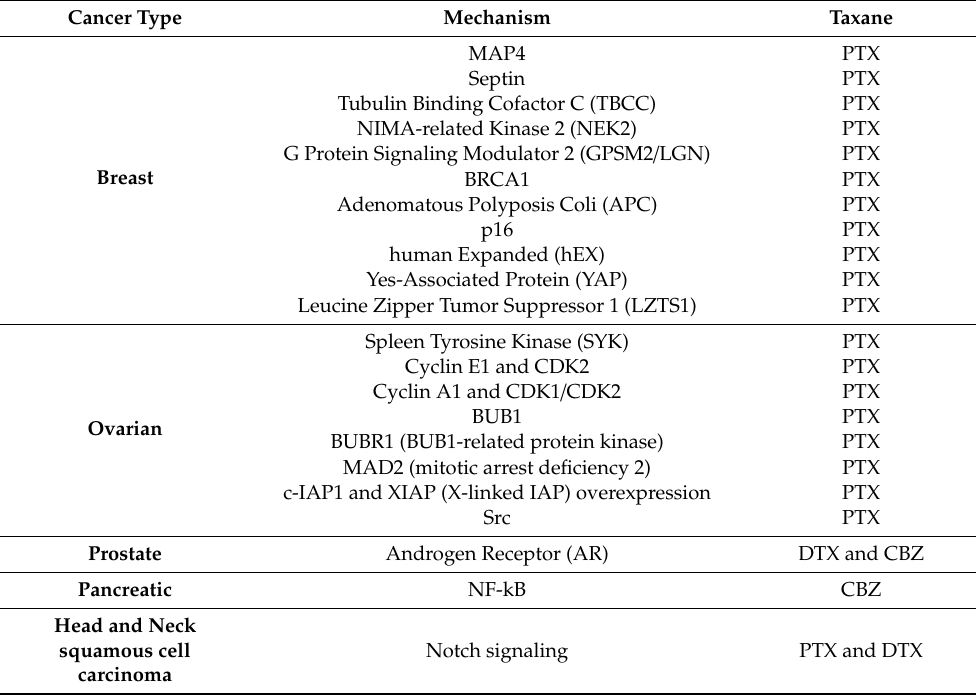
Table 2. Unique resistance mechanisms. See text for